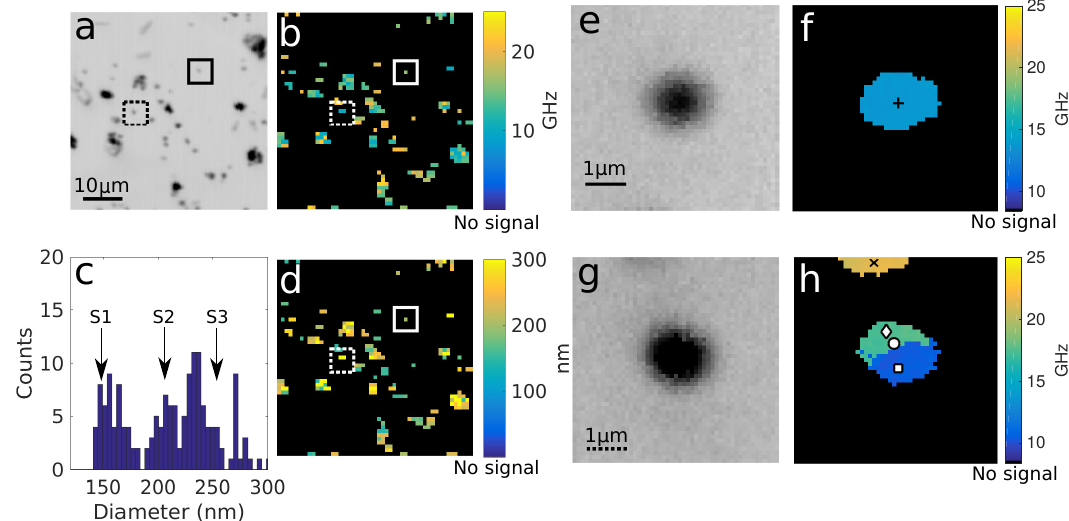
Figure 4. Sample containing a mixture of gold nanospheres of different sizes, imaged over an area of 50 × 50 µ m 2 and two 5 × 5 µ m 2 finer scans measuring transmitted light. ( a ) optical picture of the big scanned area; ( b ) ultrasonic picture showing the frequency measured; ( c ) histogram with the size distribution of particles where the arrows show the expected size of nanoparticles (150, 200 and 250 nm diameter); ( d ) ultrasonic picture showing the size of the nanospheres using the mechanical model (Section 2.4) to convert the breathing mode into size in nm; ( e , f ) are the optical and acoustic pictures, respectively, of the solid square area (5 × 5 µ m 2 ); ( g , h ) are the optical and acoustic pictures, respectively, of the dashed square area (5 × 5 µ m 2